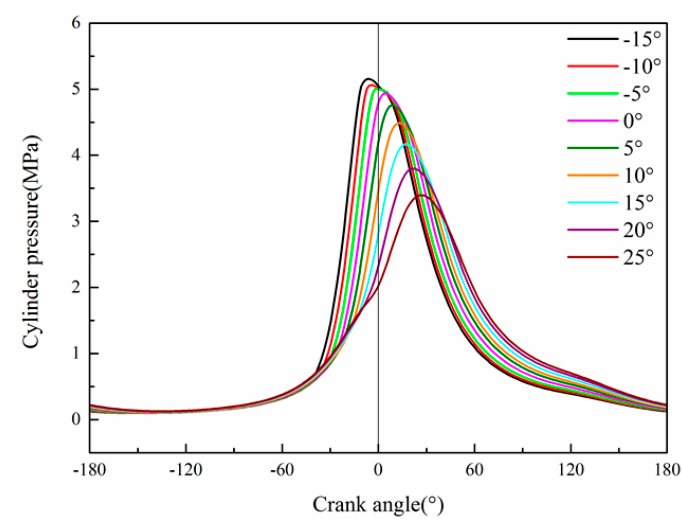
Figure 11. Influence of cylinder pressure with changes in the intake offset angle.